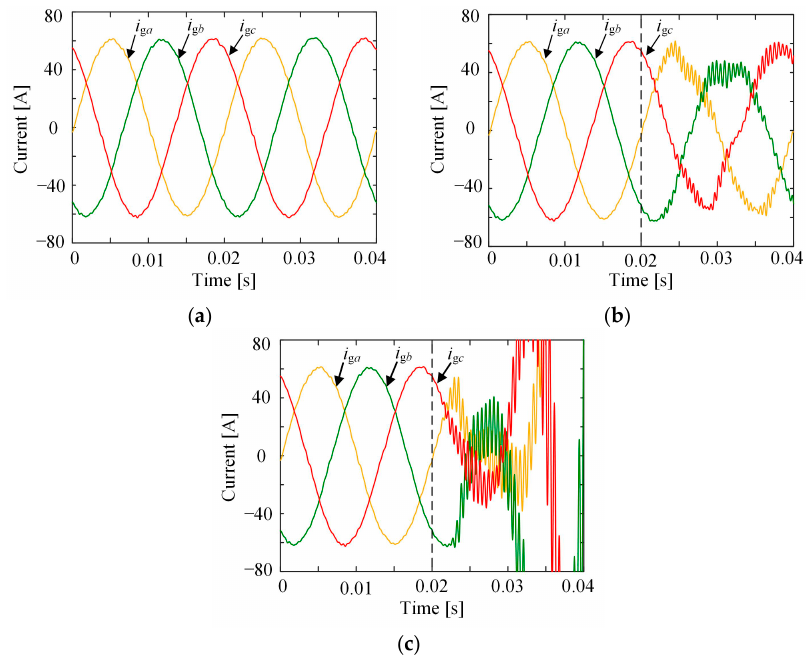
Figure 12. Steady-state full-load output current with different computation delays. ( a ) T d = 0.5 T s ; ( b ) T d = 0.75 T s ; and ( c ) T d = T s .